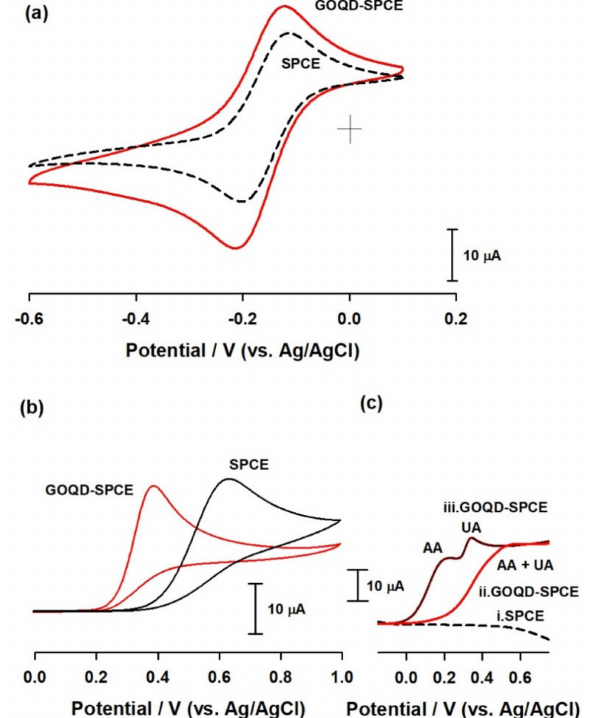
Figure 10. ( a ) Cyclic voltammograms of 1 mM [Ru(NH 3 ) 6 ]Cl 3 at a bare SPCE and sphere-like GOQD- modified SPCE (GOQD-SPCE) in 0.1 M of NaH 2 PO 4 solution at a scan rate of 50 mV/s. ( b ) Cyclic voltammograms of 1 mM of uric acid at a bare SPCE and GOQD-SPCE in 0.1 M, pH 8 PBS at a scan rate of 50 mV/s. ( c ) Linear scan voltammograms of SPCE (i) and GOQD-SPCE (ii) for simultaneous determination of ascorbic acid (AA, 1 mM) and uric acid (UA, 500 µ M), and a control response of GOQD-SPCE without any analyte